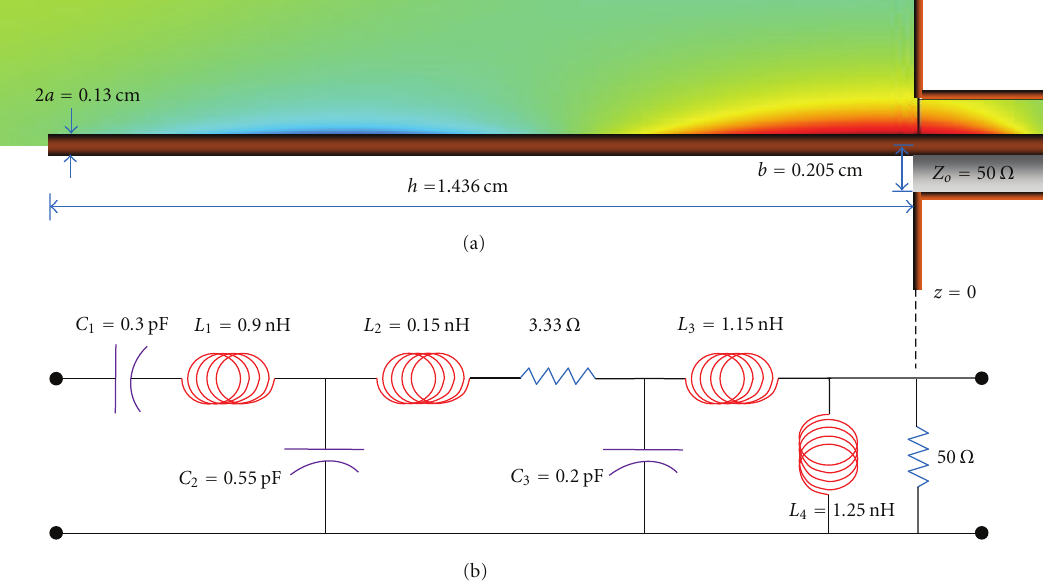
Figure 6: Dimensions of monopole and simulated electric fields contour; (b) equivalent circuit for input impedance of monopole at z = 0.